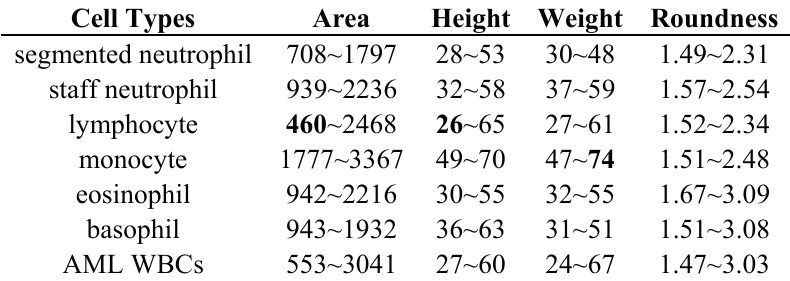
h , h ) = (13,1); ( d ) Segmented with ( s r Table 1. Characteristic parameters for seven types of WBCs.